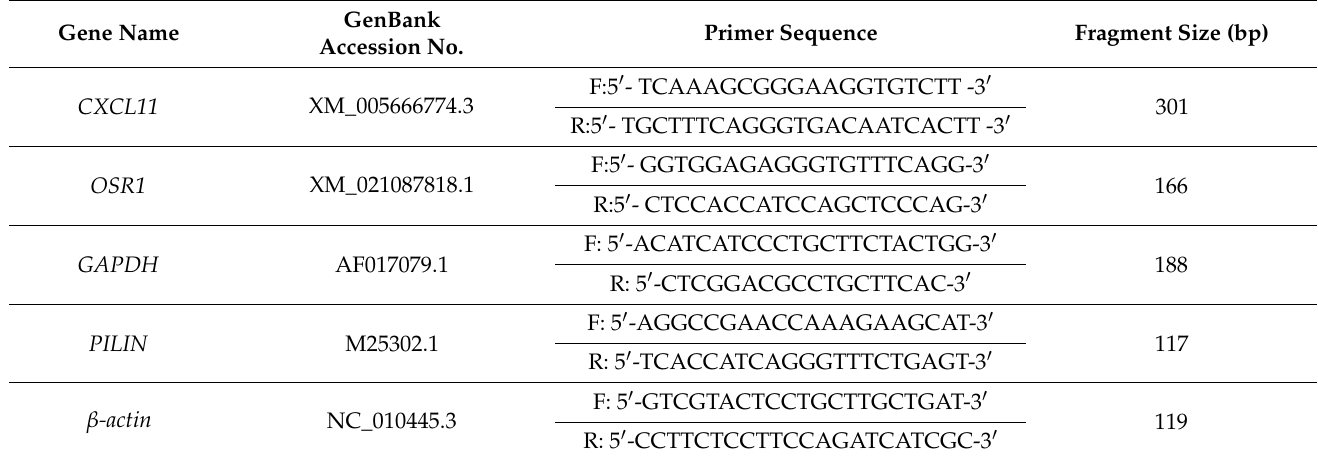
Table 1. The qPCR primers